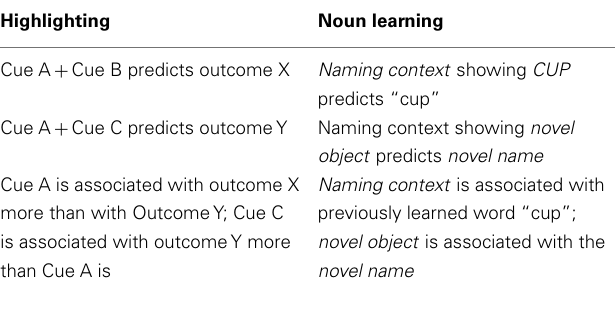
Table 1 | Parallel structure of highlighting and noun learning. Highlighting Noun learning Naming context showing CUP Naming context showing